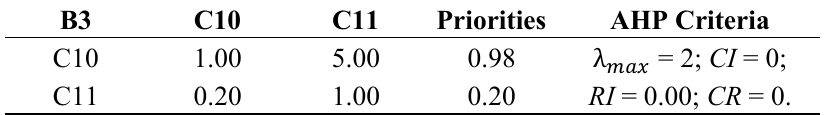
Table 5. Judgment matrix of the criterion B3 and its related factors.